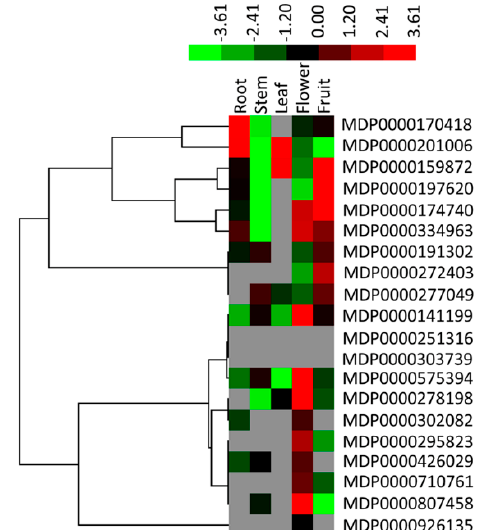
Figure 5. Expression profiles of MdMDHs in five tissues, including fully bloomed flowers (Flower), Root, mature leaf (Leaf), ripening fruit (Fruit) and Stem. The heat map was generated by Mev software based on relative expression levels of MdMDHs , and normalized log2 transformed values were used with hierarchical clustering. The different colors represent different expression level, with the red color representing the highest value of gene expression.